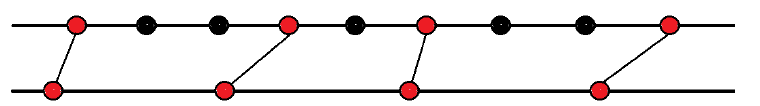
Figure 10. Message synchronization by approximate time algorithm and zero padding. The red dots indicate the taken measurements, black dots indicate the opt out measurements and do zero padding to the merge message in